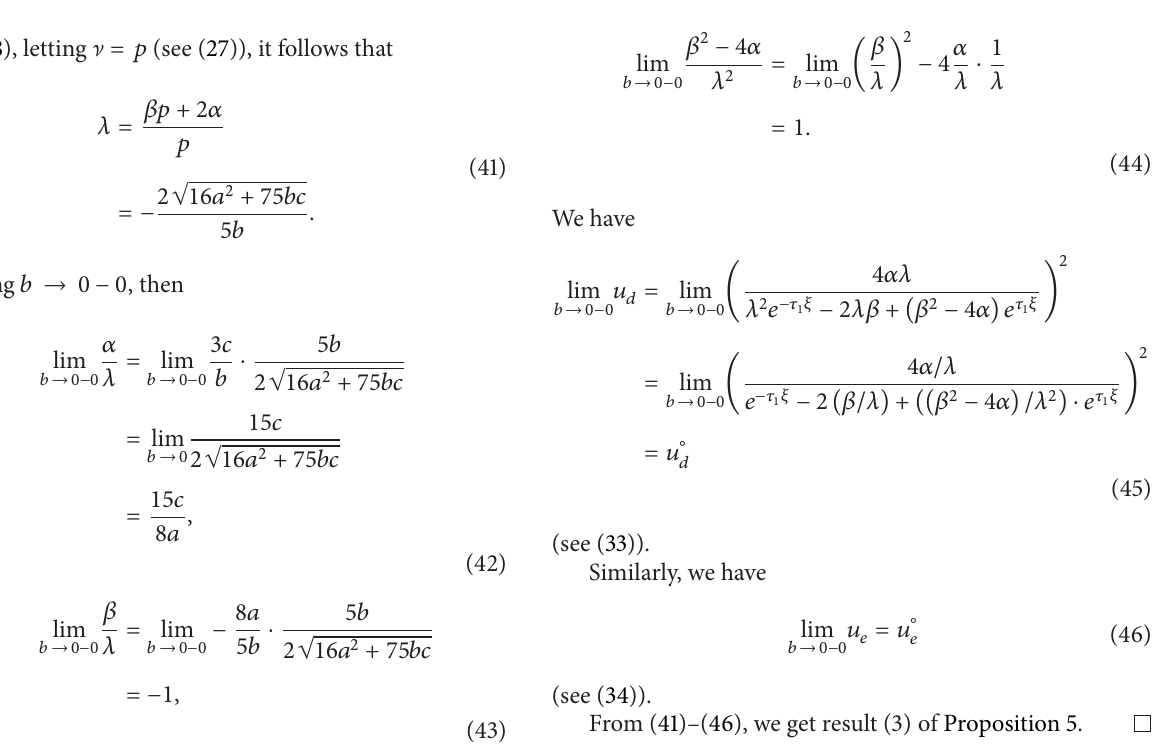
Figure 17: (The antikink wave is bifurcated from the compacton-like wave). The varying process for the graph of 𝑢 − 𝑐 when 𝑐 > 0 , 𝛿 > 0 , 𝑎 > 0 , and 𝑏 → −16𝑎 2 /75𝑐 + 0 , where 𝑐 = 1 , 𝛿 = 1 , 𝑎 = 1/2 , and (a) 𝑏 = −16𝑎 2 /75𝑐 + 10 −3 . (b) 𝑏 = −16𝑎 2 /75𝑐 + 10 −4 . (c) 𝑏 = −16𝑎 2 /75𝑐 + 10 −6 . (d) 𝑏 = −16𝑎 2 /75𝑐 + 10 −8